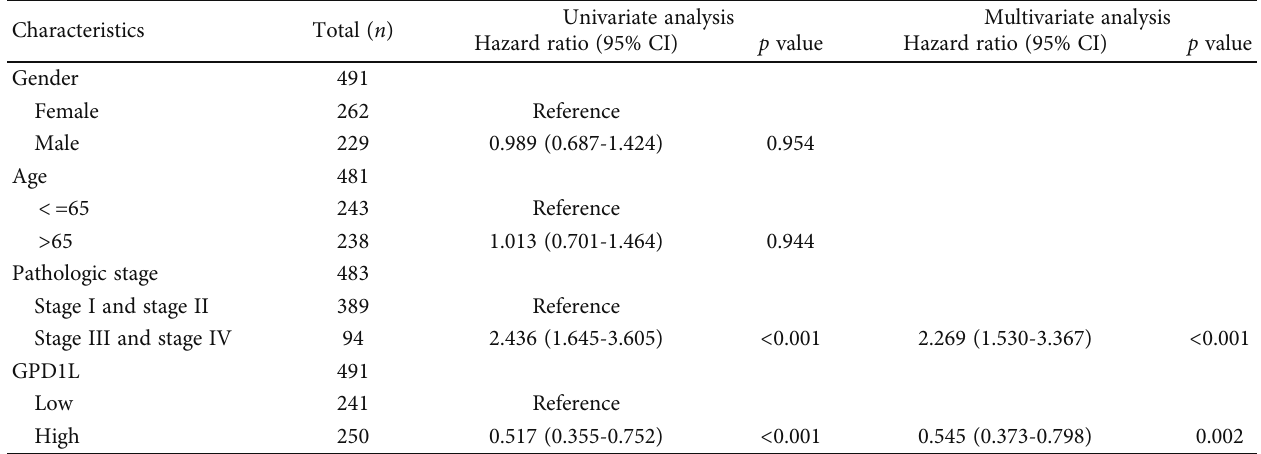
Table 3: Univariate and multivariate analysis of disease-speci fi c survival in LUAD